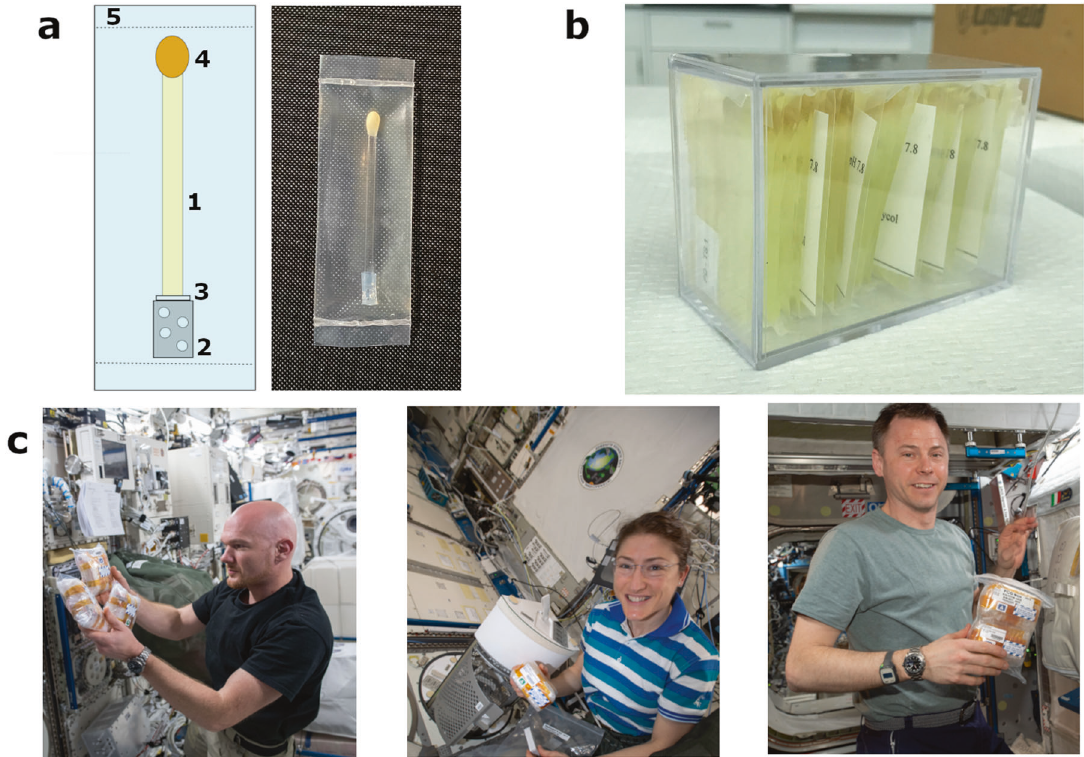
Fig. 2 The TCB setups and fl ight handling. a Schematic of TCB capillary (left) with components indicated: (1) 2 mm inner diameter quartz capillary, 5 cm in length, fi lled with protein solution; (2) perforated Tygon tube cut to 1 cm length; (3) a 5 mm circular 3 – 5 kDa MWCO dialysis membrane fi t over the end of the capillary; (4) beeswax seal; (5) heat-sealed polypropylene bag containing mother liquor. A photo of an assembled TCB capillary is shown (right). b A fi lled TCB containing 50 individual crystallization experiments. The boxes are sealed in liquid containment bags, wrapped in bubble wrap using mylar tape. c ESA Astronaut Alexander Gerst (left), NASA Astronauts Christina Koch (middle) and Nicklaus Hague (right) transferring sealed TCB devices into ambient storage lockers on the ISS. Photo credit: